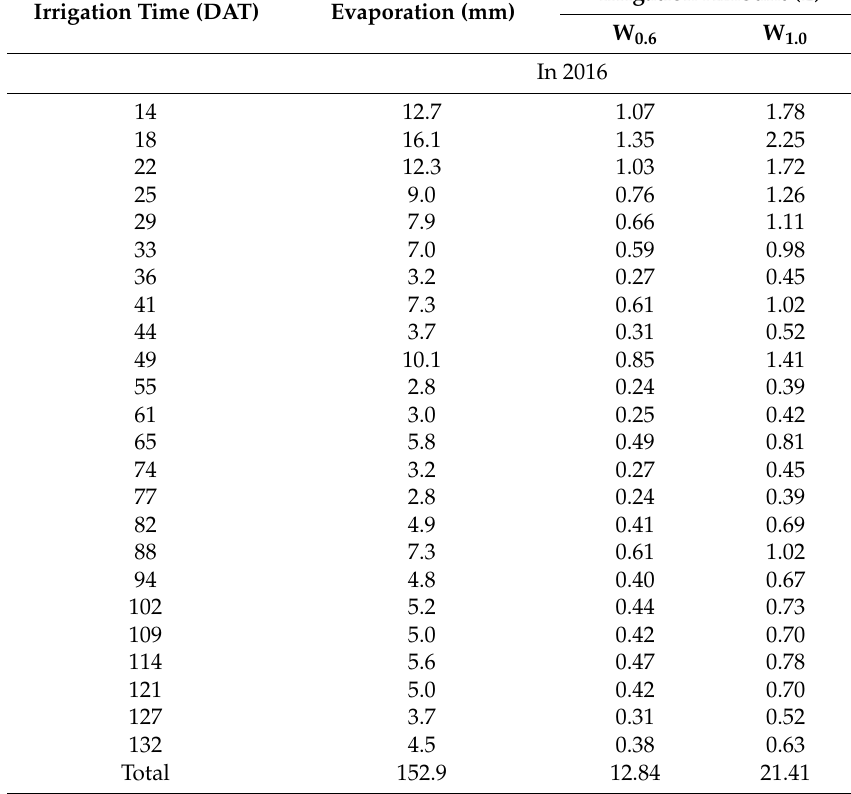
Table 1. Irrigation time and amount during the two consecutive greenhouse tomato-growing seasons. Irrigation Time